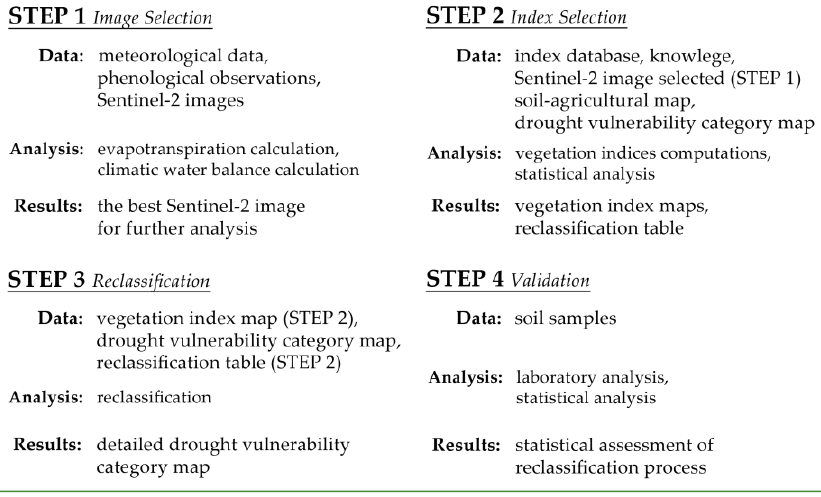
Figure 3. The steps of the analysis.